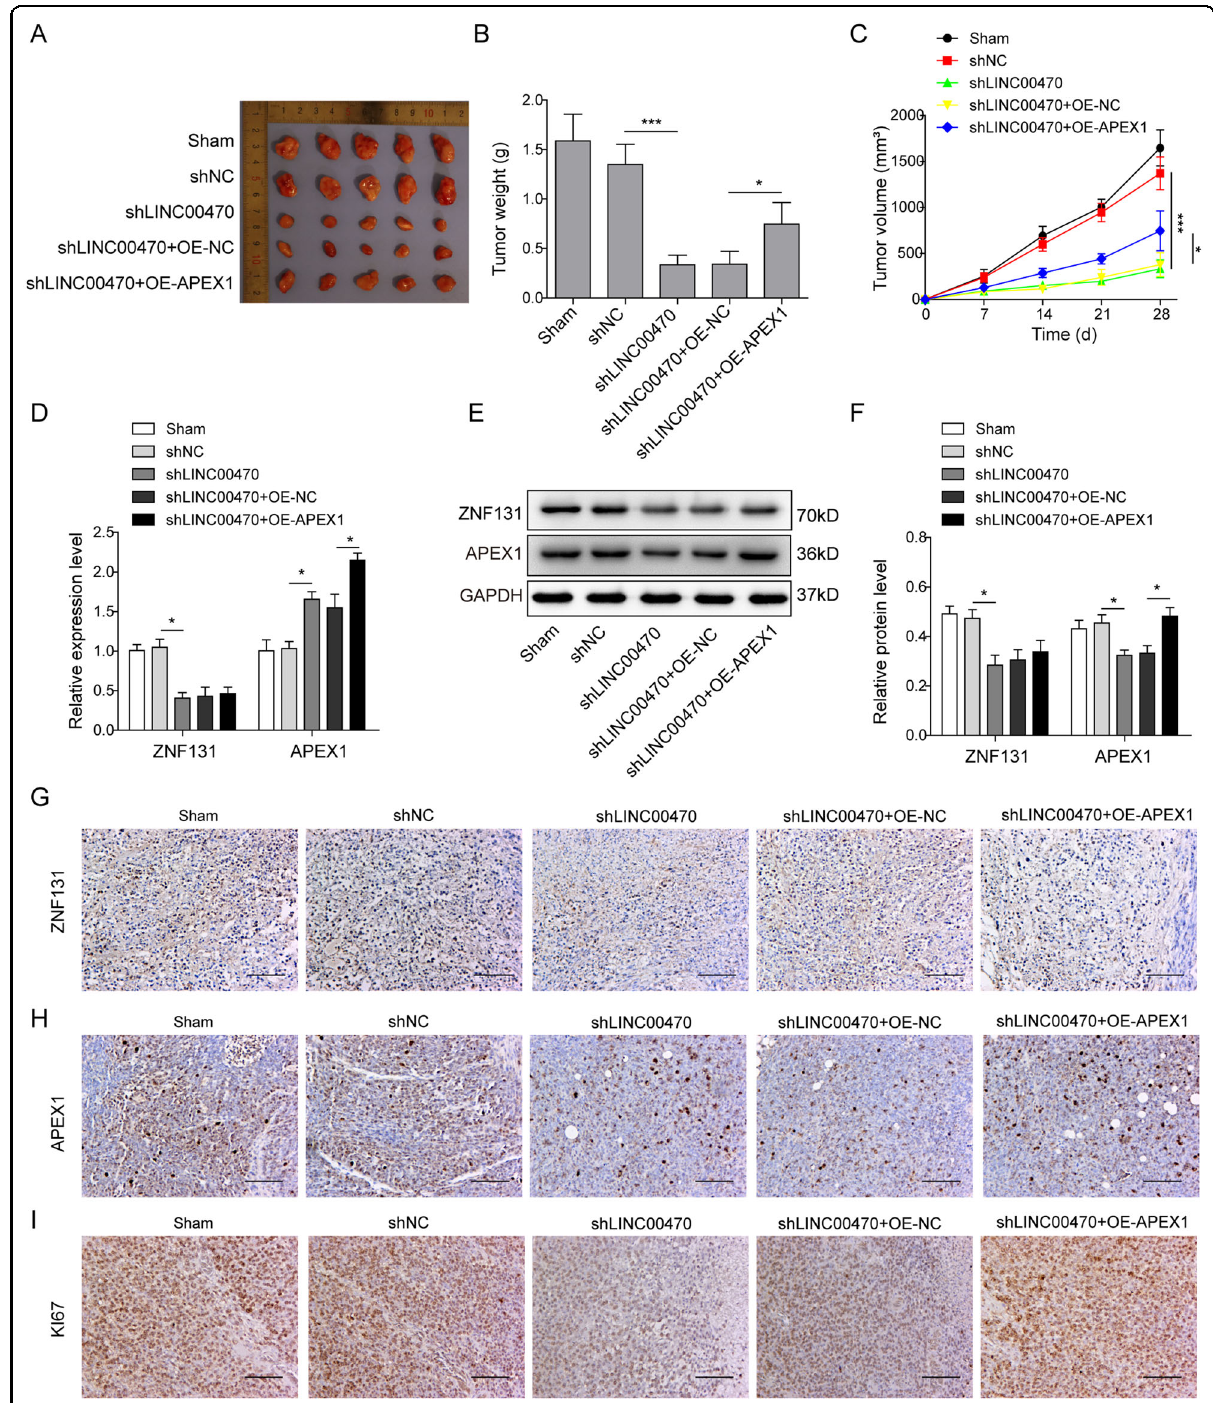
Fig. 7 LINC00470 promoted melanoma proliferation and metastasis through enhancing APEX1 expression in vivo. A Xenografts were shown after transfecting with shNC, shLINC00470, shLINC00470 + OE-NC, and shLINC00470 + OE-APEX1, respectively. B Tumor weight of different groups at day 28. C Tumor growth was monitored by analyzing tumor volume for 28 days. D Levels of ZNF131 and APEX1 in different groups as described in panel A were analyzed by qRT-PCR. E , F Levels of ZNF131 and APEX1 in different groups as described in panel ( A ) were analyzed by Western blot. G – I The immunohistochemical staining was conducted to determine the expression of ZNF131 ( G ), APEX1 ( H ), ki67 ( I ) in different groups as described in panel ( A ). The mean ± SD in the graph shows the relative levels from three replicates. * p < 0.05, ** p <